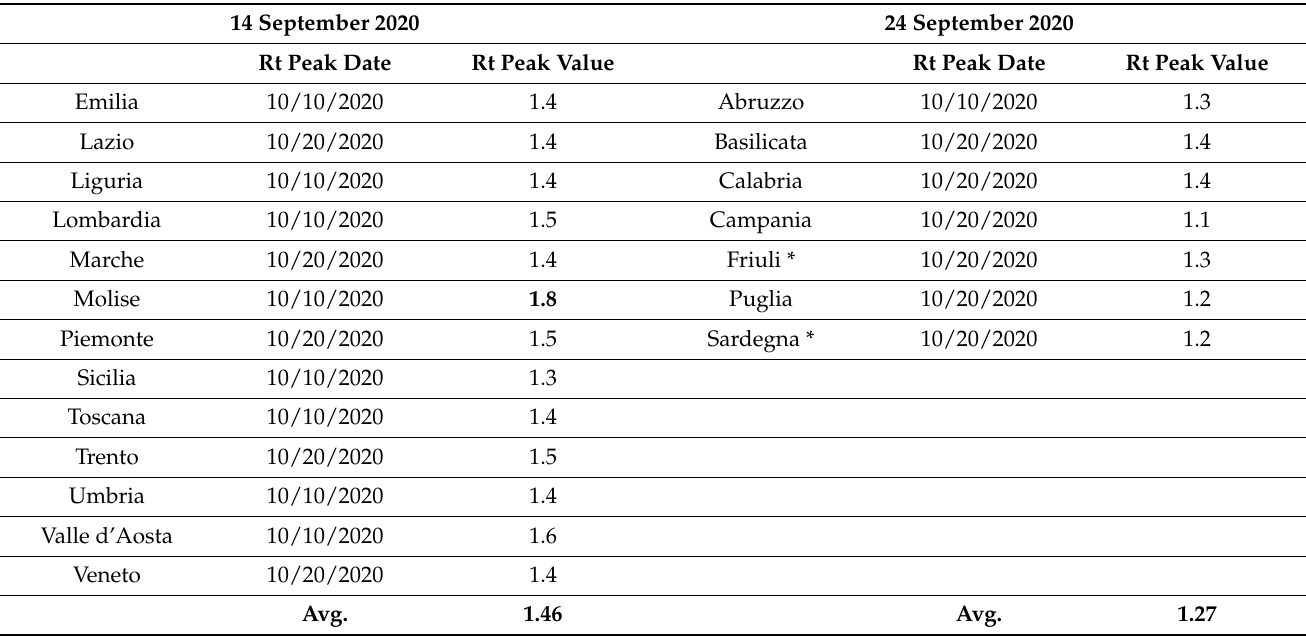
Table 2. Rt peak values and dates associated to Italian